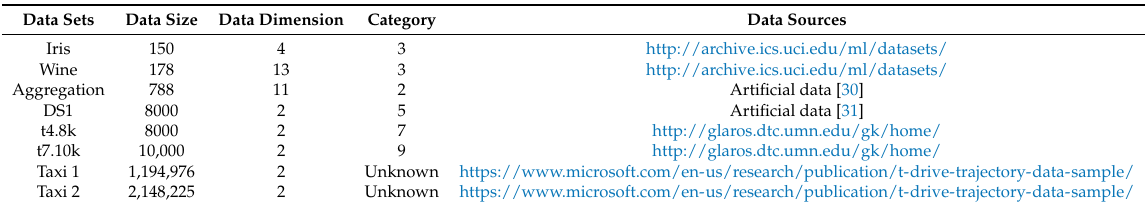
Table 2. Test data